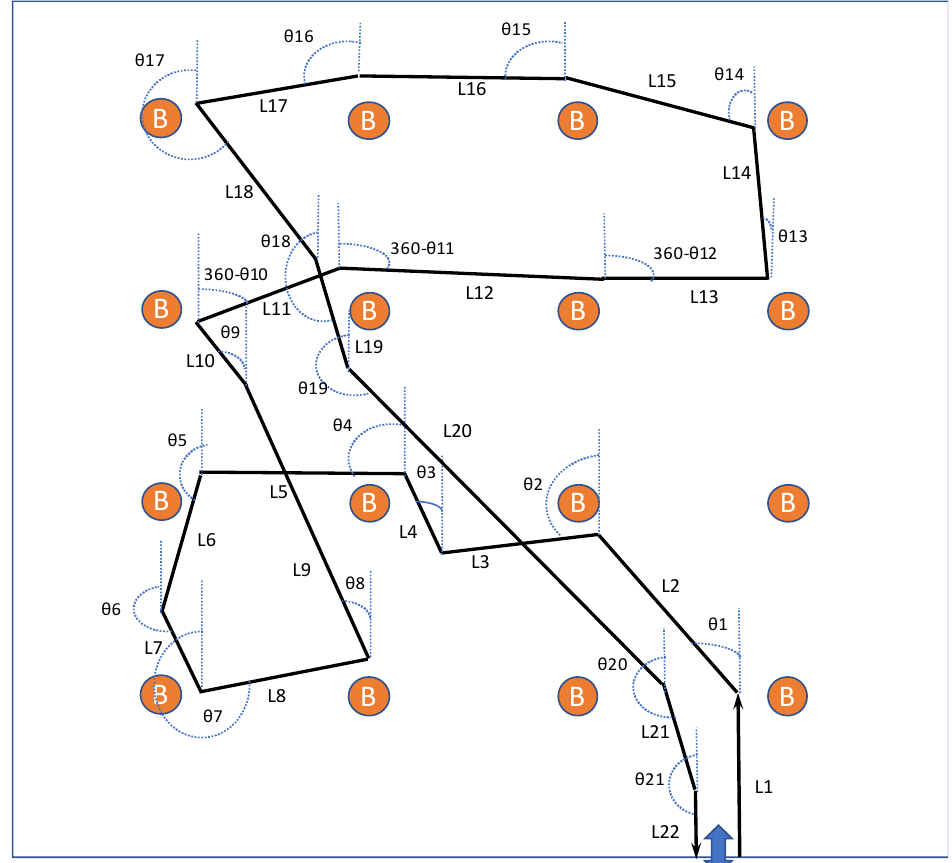
Figure 8. Schematic depiction of the tracking capability of the proposed hybrid indoor positioning mechanism enhancing inertial dead reckoning with proximity processing of BLE beacons deployed in the indoor environment. The figure illustrates the independent travel of a BVI subject inside an indoor space, from entrance to exit, and the real-time tracking of the motion trajectory, modeled using rectilinear signals and orientations, implemented by the proposed indoor positioning mechanism. When the BVI goes near to a beacon, the distance of the BVI to the beacon is very accurately determined (see next section) and therefore the system can correct the potential error of the estimated motion trajectory, as well as re-valuate the inertial dead reckoning parameters towards the ensuing tracking.